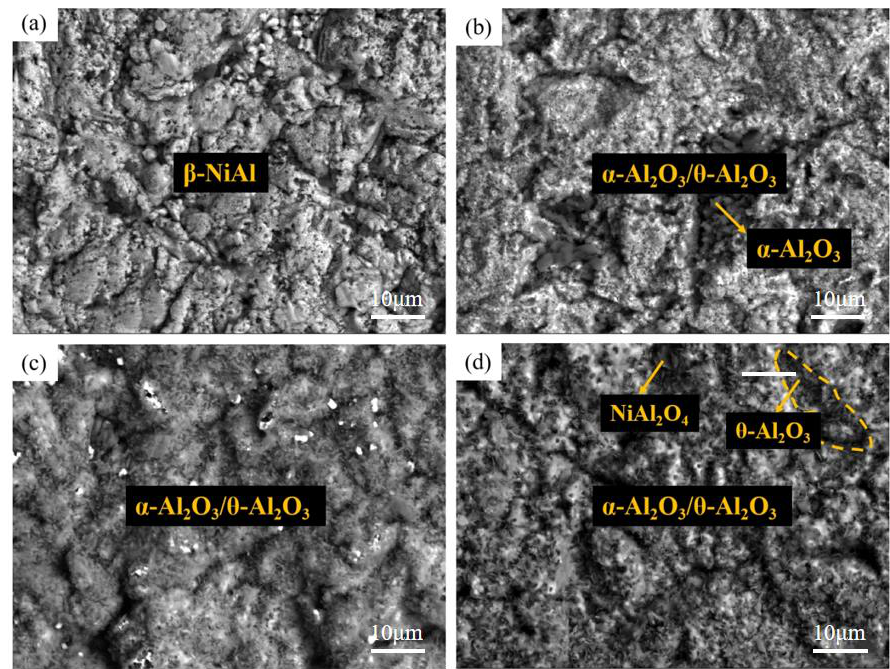
Figure 3. The surface morphologies of the coating after pre-oxidation at different temperatures for 1 h: ( a ) untreated; ( b ) 900 °C; ( c ) 950 °C; ( d ) 1000 °C.